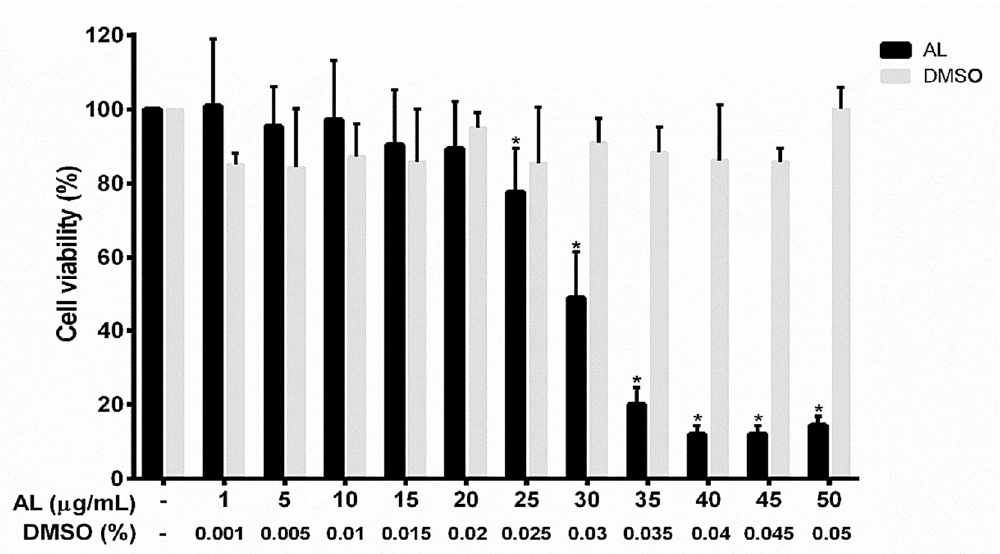
Figure 2. Effects of AL extract on cell viability in RAW 267.4 cells. The bars indicate percent cell viability of cells treated with AL extract with the indicated concentrations (ranging from 0 to 50 µ g / mL) for 48 h, and subjected to 3-(4,5-dimethylthiazol-2-yl)-2,5-diphenyltetrazolium bromide (MTT) assay. Data are representatives of three replicates and shown as mean ± SD; * p < 0.05 (compared to the untreated group).